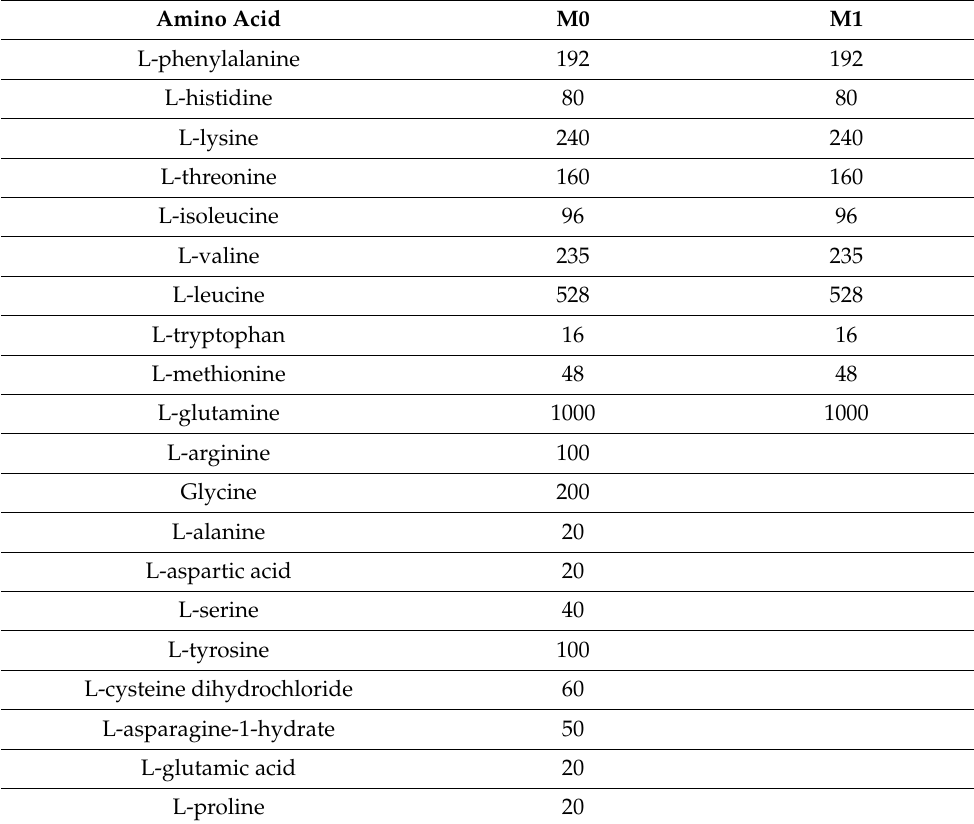
Table 1. Composition of M0 (complete medium) and M1 (selective AA restricted medium) in mg/L. Amino Acid M0 M1 L-phenylalanine